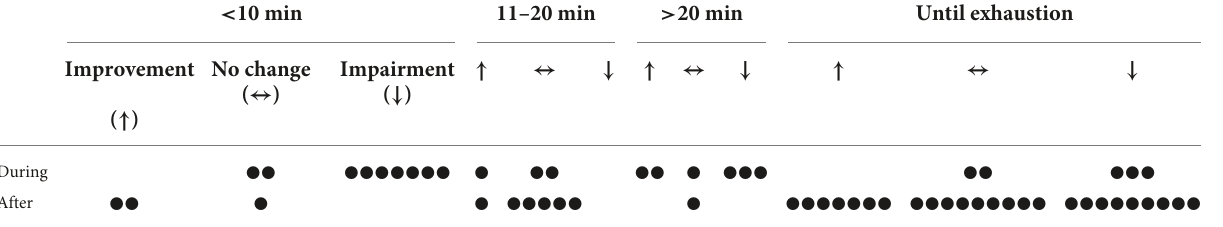
TABLE 5 Summary of impacts of exercise